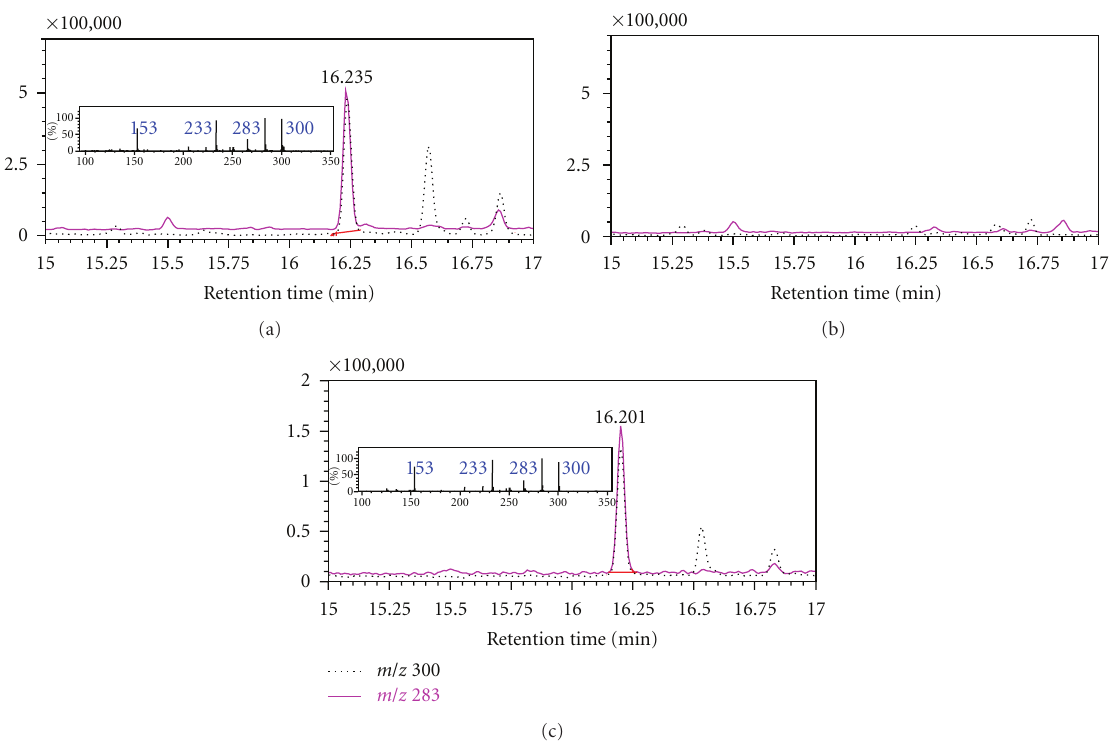
Figure 6: Detection of JHSB 3 ( 1 ) from the hemolymph of Plautia stali females. Hemolymph samples collected from reproductively active (a) and diapausing females (b), and 10 ng of synthetic standard of JHSB 3 (c) were analyzed on GC-MS using a DB-35MS column. Vertical axis indicates signal intensity for m/z 283, [M+H] + (solid line) and m/z 300, [M+NH 4 ] + (dotted line). Insets in a and c indicate a mass spectrum of the peak at 16.2 min [14].